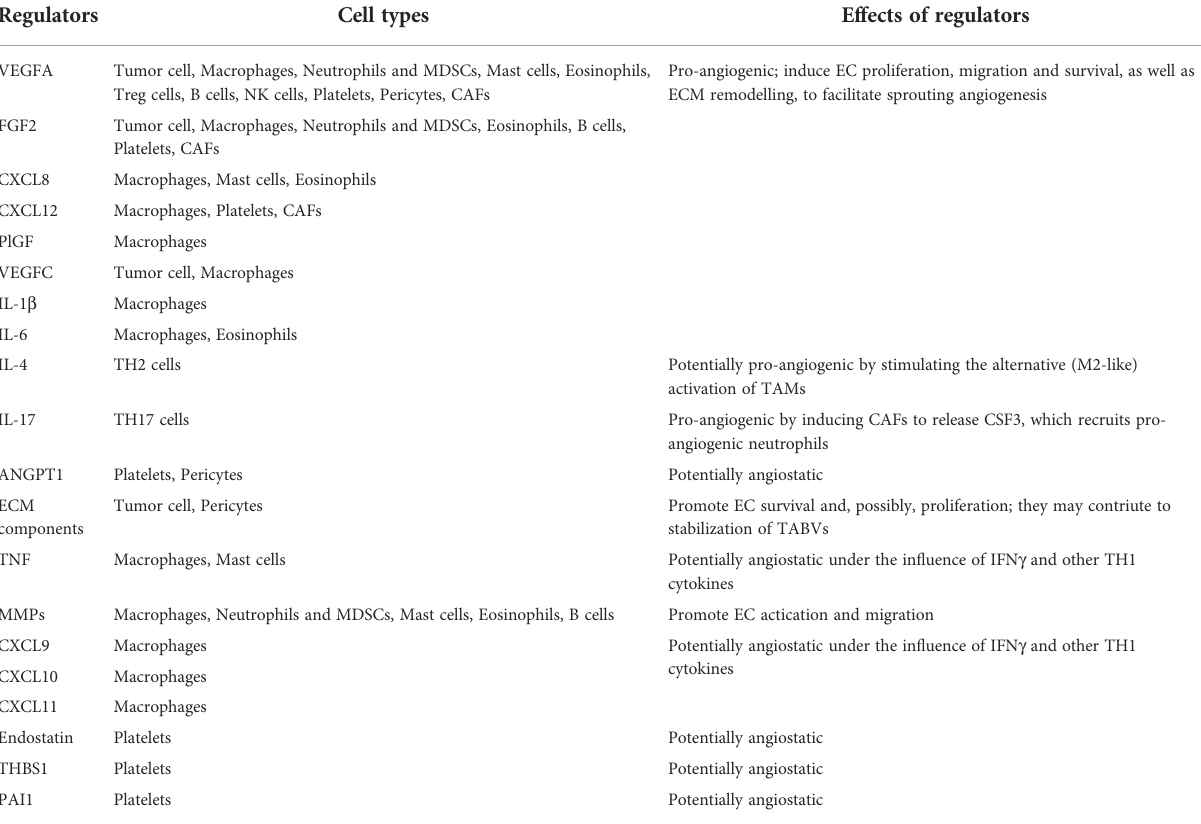
TABLE 1 The sources and effects of the sources tumor vasculogenesis